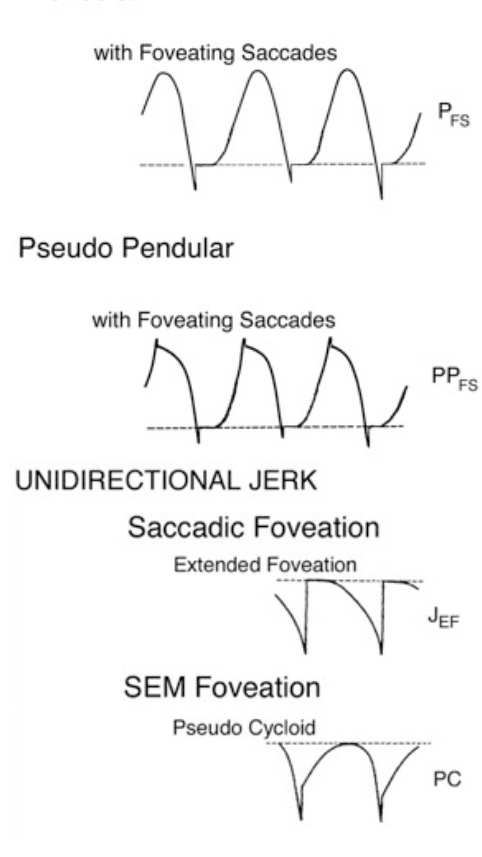
FIGURE 1. Common and pathognomonic pendular and unidirectional jerk INS waveforms showing the target position and intervals of extended foveation. Shown are pendular with foveating saccades (P FS ), pseudopendular with foveating saccades (PP FS ), jerk with extended foveation (J EF ), and pseudocycloid